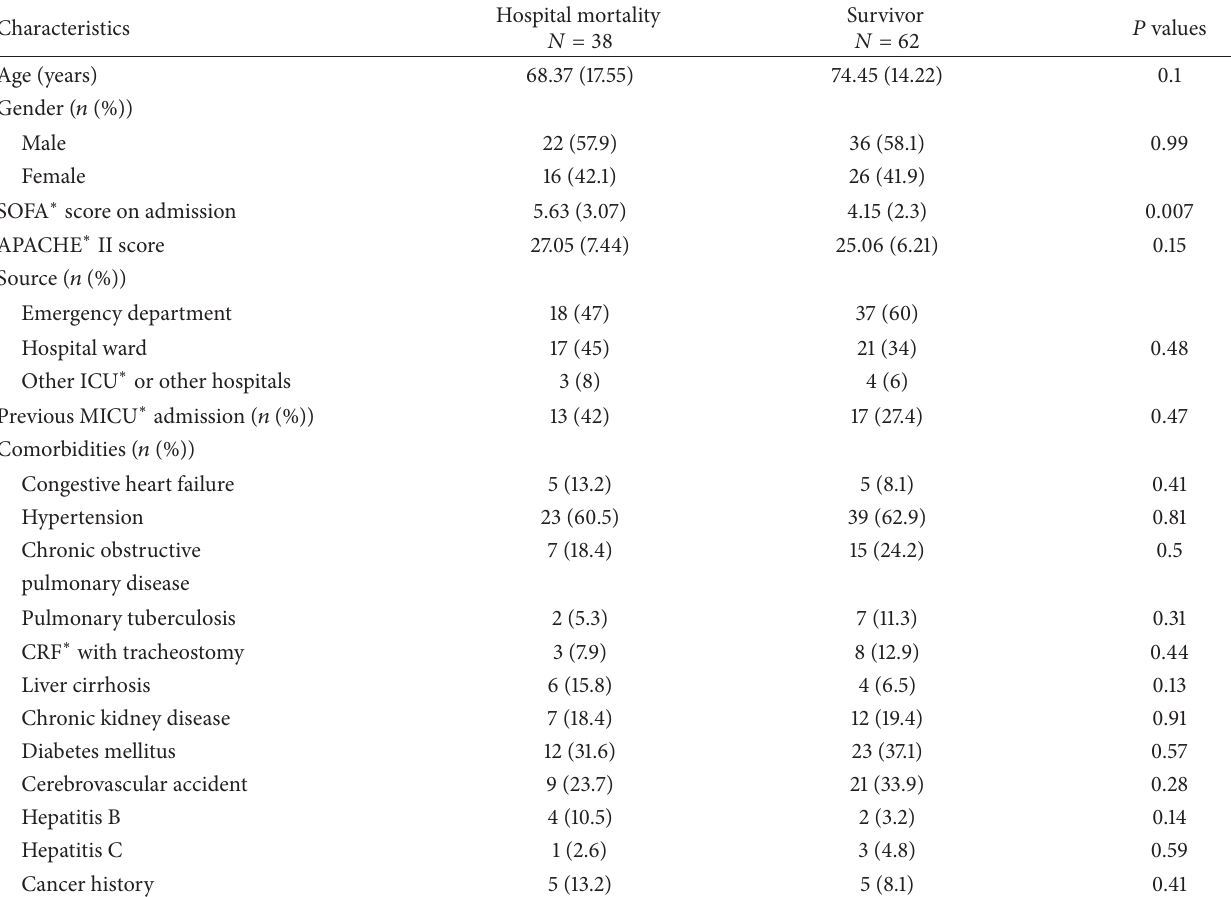
Table 3: Characteristics of survivors and nonsurvivors: bivariate analysis #